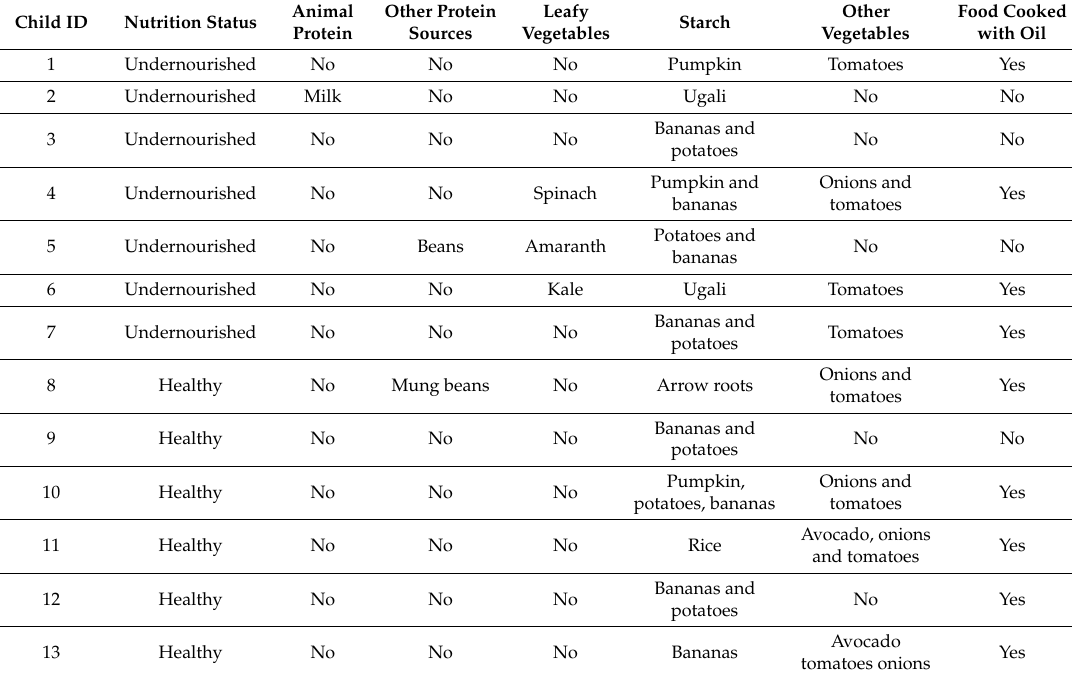
Table 3. Foods o ff ered during meal